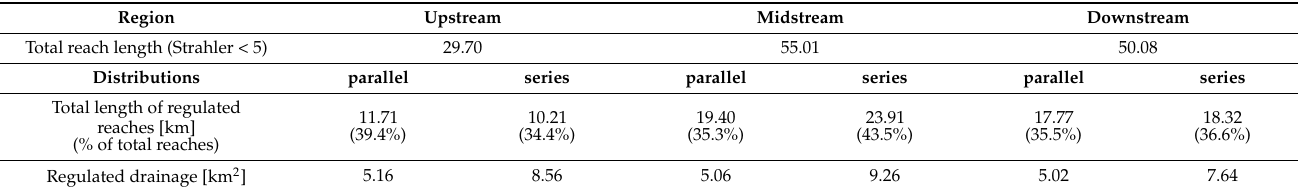
Table 2. Geometric characteristics of regulated areas and reaches for in-parallel and in-series